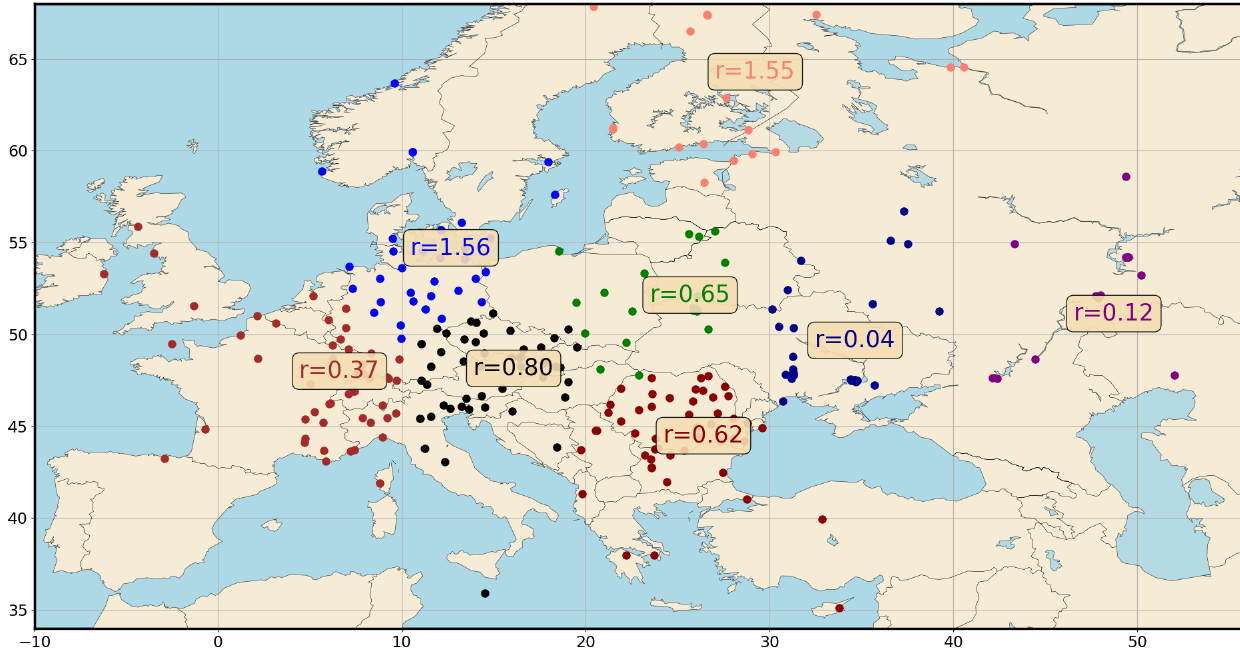
Figure 3. 106 Ru observations spatially clustered with a k means algorithm ( k = 9). The means of the corresponding nine variance distribu- tions have been computed using a parallel tempering algorithm for a log-normal distribution with a threshold equal to 0 . 5mBqm − 3 . The observation-sorting algorithm is applied and “eliminates” the low-uncertainty